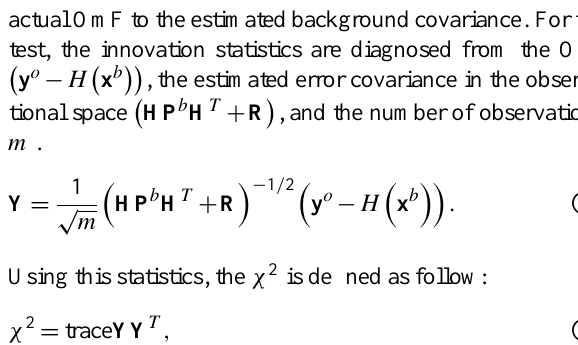
Fig. 5. Temporal variation of the χ 2 calculated as values estimated in each data assimilation cycle (thin line) and 15-orbit cycle running means (bold line). Table 3. The four-month mean (January, April, July, and Oc- tober in 2005) global and regional NO x emissions (inTgNyr − 1 ) obtained from the a priori emissions, the a posteriori emis- sions with DOMINO v2 data, and the newer